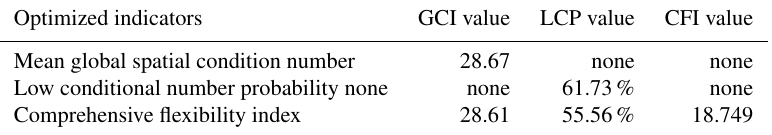
Table 3. Optimized objective function